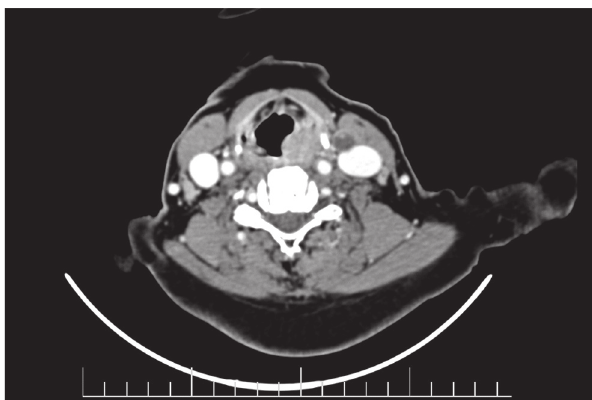
Figure 1: CT scan, axial view. There is an abnormal enhancing mass in the left pyriform sinus.